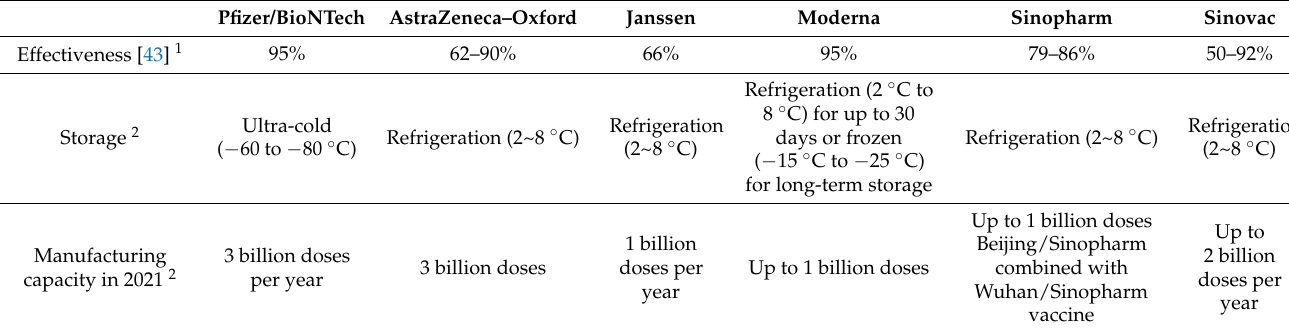
Table 1. Effectiveness, storage, and manufacturing capacity of EUL COVID-19 vaccines. Pfizer/BioNTech